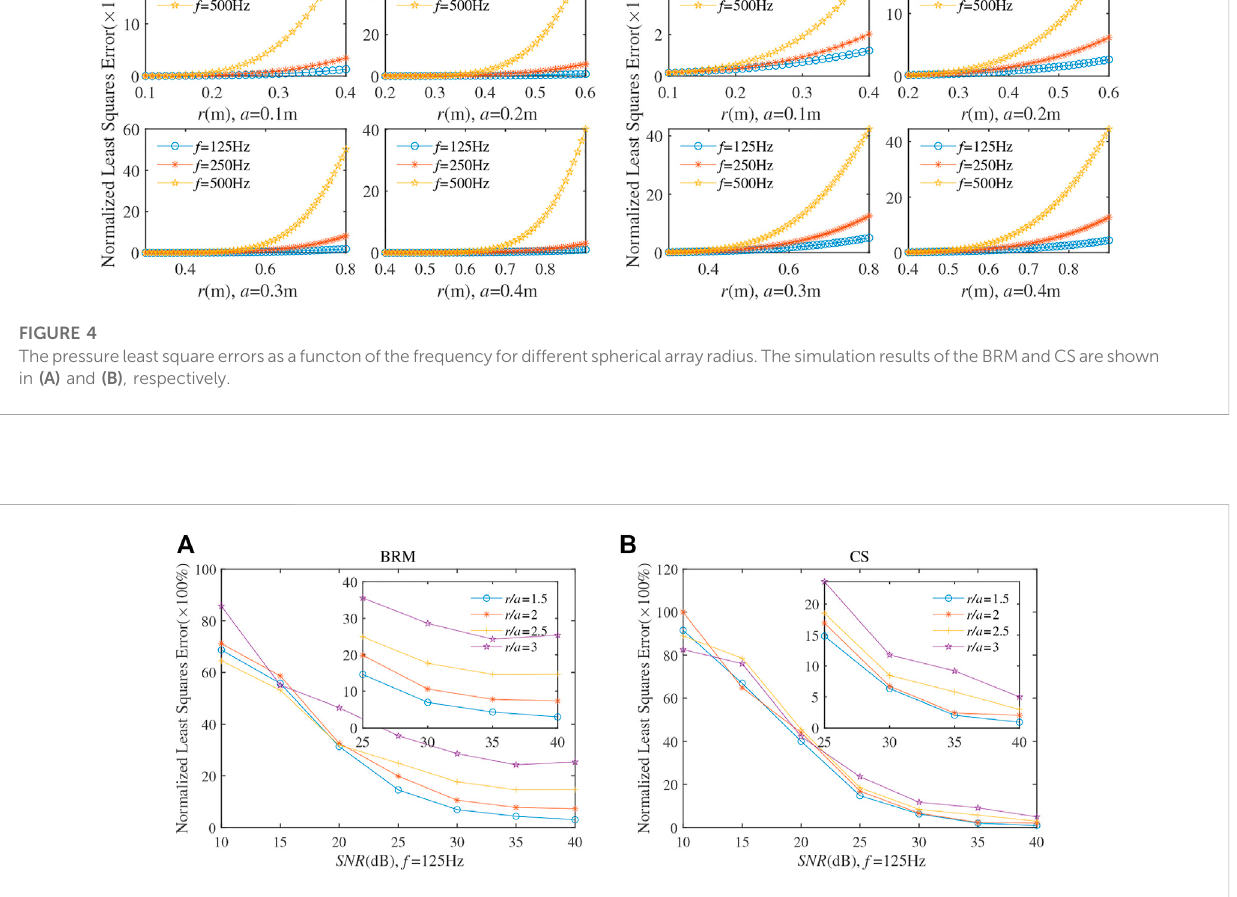
FIGURE 5 The pressure least square errors as a function of SNR at 125 Hz. The simulation results of the BRM and CS are shown in (A) and (B) , respectively.